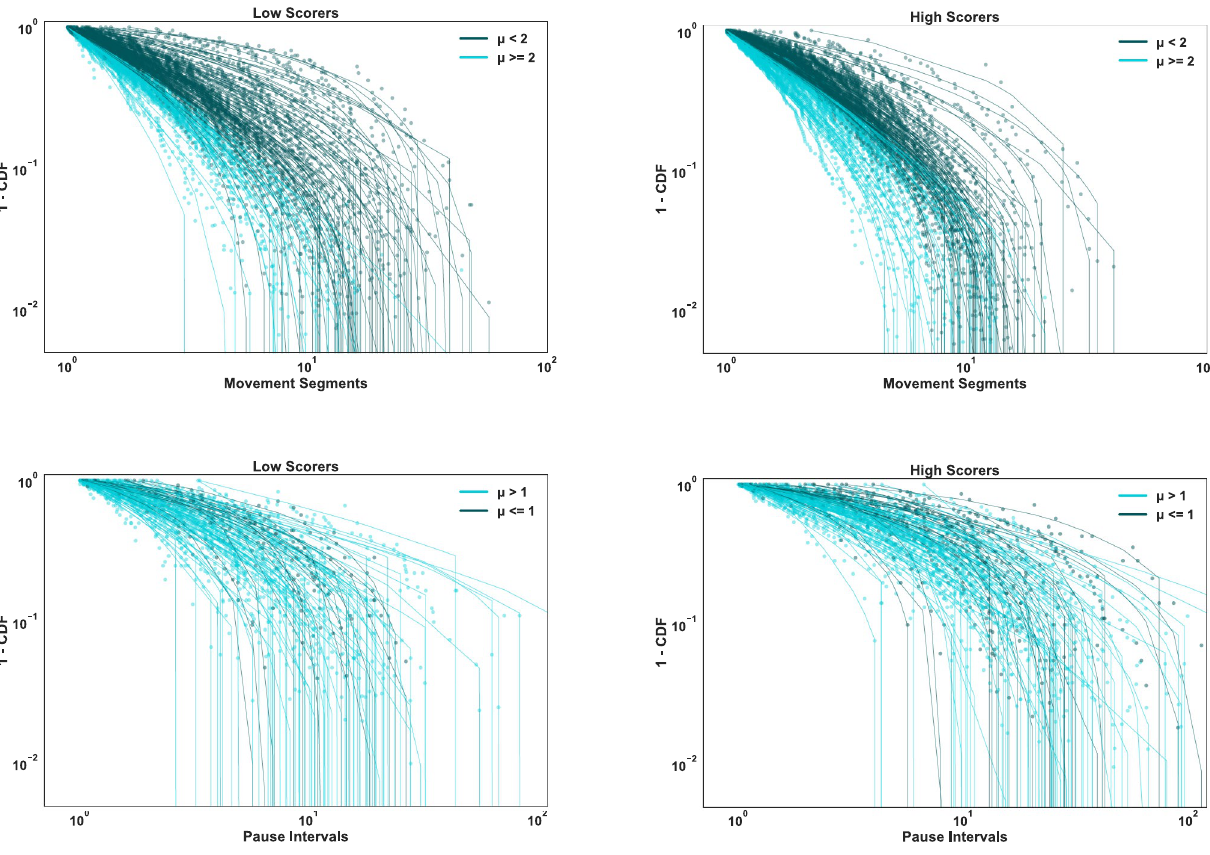
Figure 4. Complementary Cumulative Distribution Function (CCDF or 1 - CDF) for movement segments ( top row ) and pause intervals ( bottom row ) for all low scorers and high scorers. The points represent the empirical data and solid lines show the corresponding truncated power-law fits (using Eq. (2) where µ is the maximum likelihood estimate for a given empirical distribution, and x min is set to 1 sec). Lines are colored to show the boundaries of µ = 2 for movement segments and µ = 1 for pause intervals.